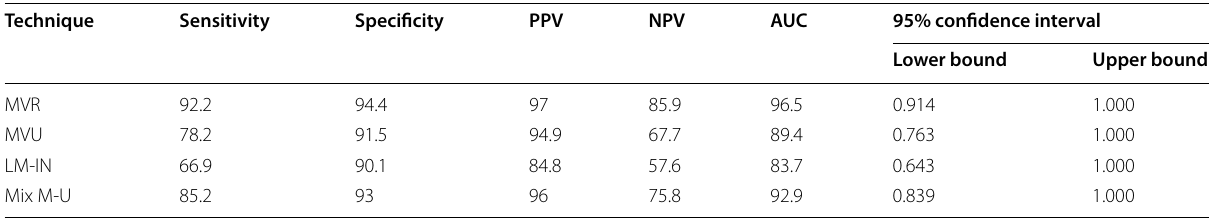
PPV , positive predictive value; NPV , negative predictive value; AUC , area under curve; MVR , median versus ulnar sensory study; MVU , median versus ulnar sensory study; LM-IN , median versus ulnar lumbrical‑ interossei motor study; Mix M-U , median versus ulnar palmar mixed nerve study